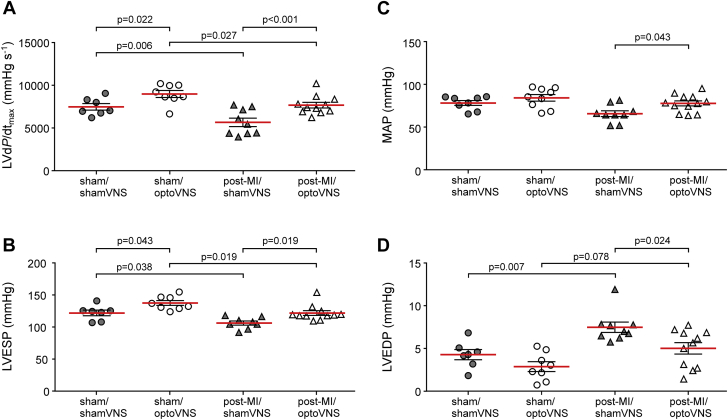
Optogenetic Stimulation of Vagal Efferent Activity Preserves LV Function in MI -Induced Heart Failure in RatsSummary data illustrating the values of (A) the maximum first differential of LV pressure (LV dP/dtmax), (B) LV end-systolic pressure (LVESP), (C) mean arterial blood pressure (MAP), and (D) LV end-diastolic pressure (LVEDP) in rats transduced to express eGFP or ChiEFtdTomato by the DVMN neurons after 4 weeks of light stimulation commencing 2 days after the occlusion of the left anterior descending artery or sham surgery. Data are presented as individual values and mean ± SEM. Comparisons are made using 2-way analysis of variance followed by Sidak’s correction for multiple comparisons. Abbreviations as in Figures 1 and 2.